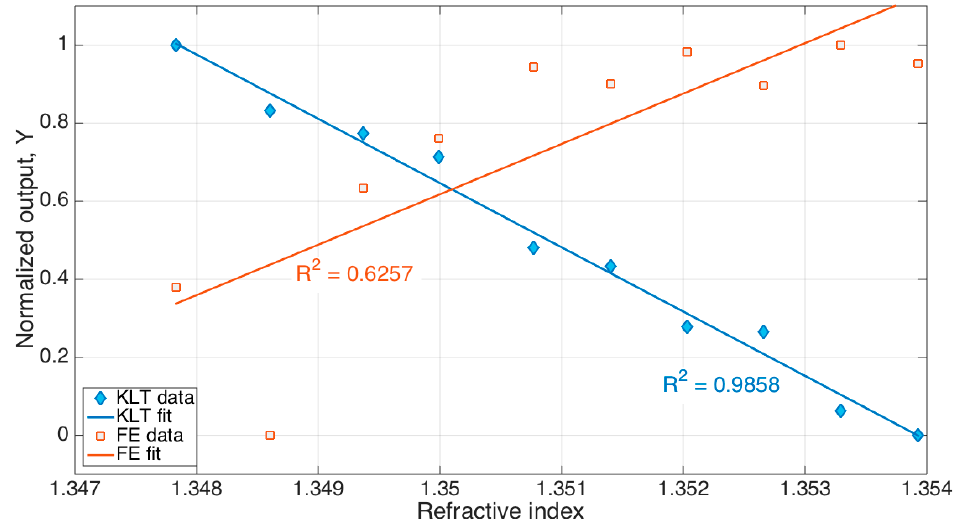
Figure 9. Comparison between KLT and feature extraction (FE) methods for demodulation of the ball resonator. The chart shows the normalized output ( Y ) as a function of the RI, obtained for each method. Datapoints have been interpolated with a linear fit; the R 2 coefficient of determination shows the quality of the agreement between measured data and the fit.